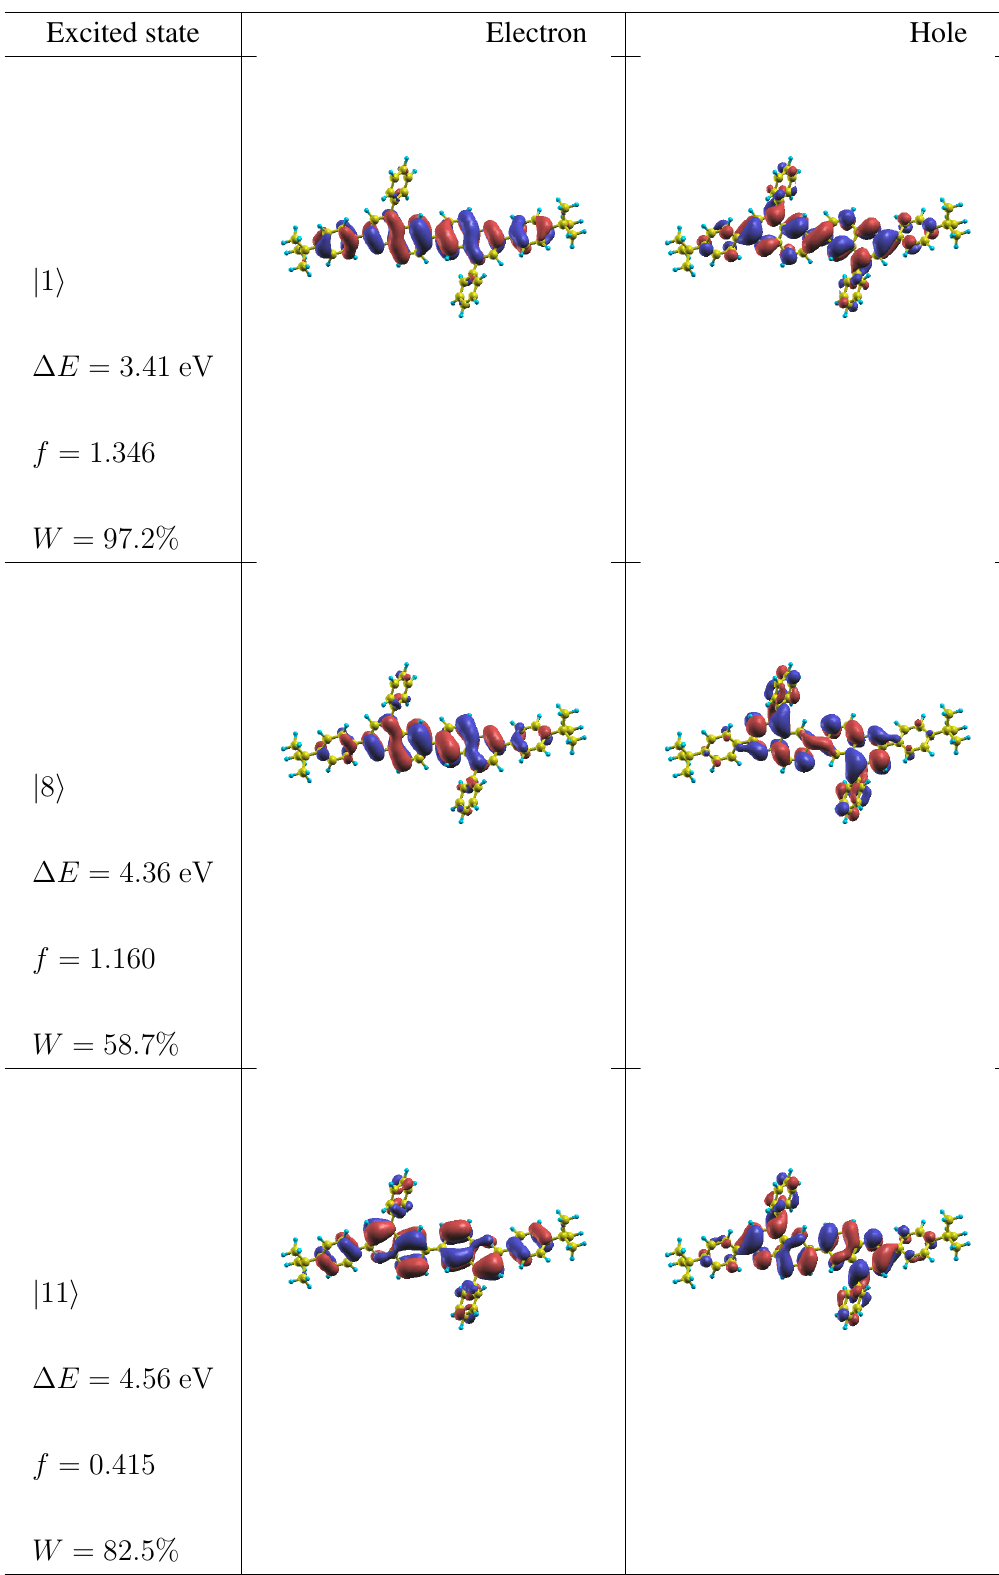
Table 18. The same as Table 17, but for